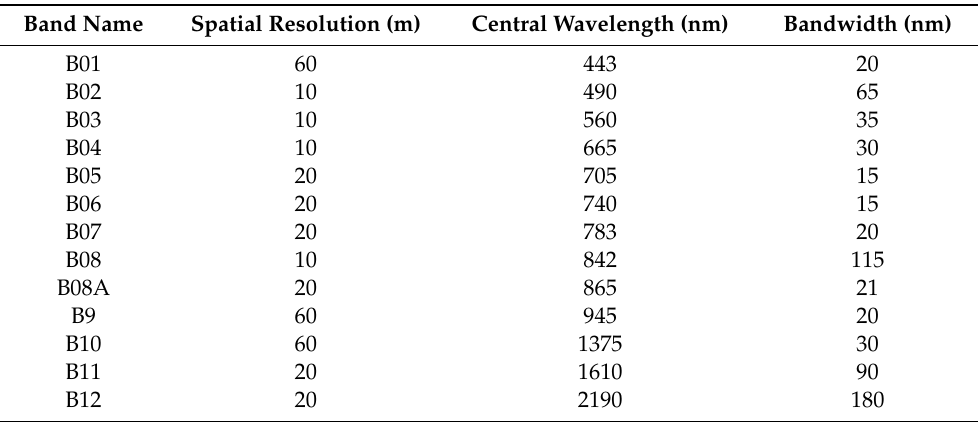
Table 1. Wavelengths of Sentinel-2